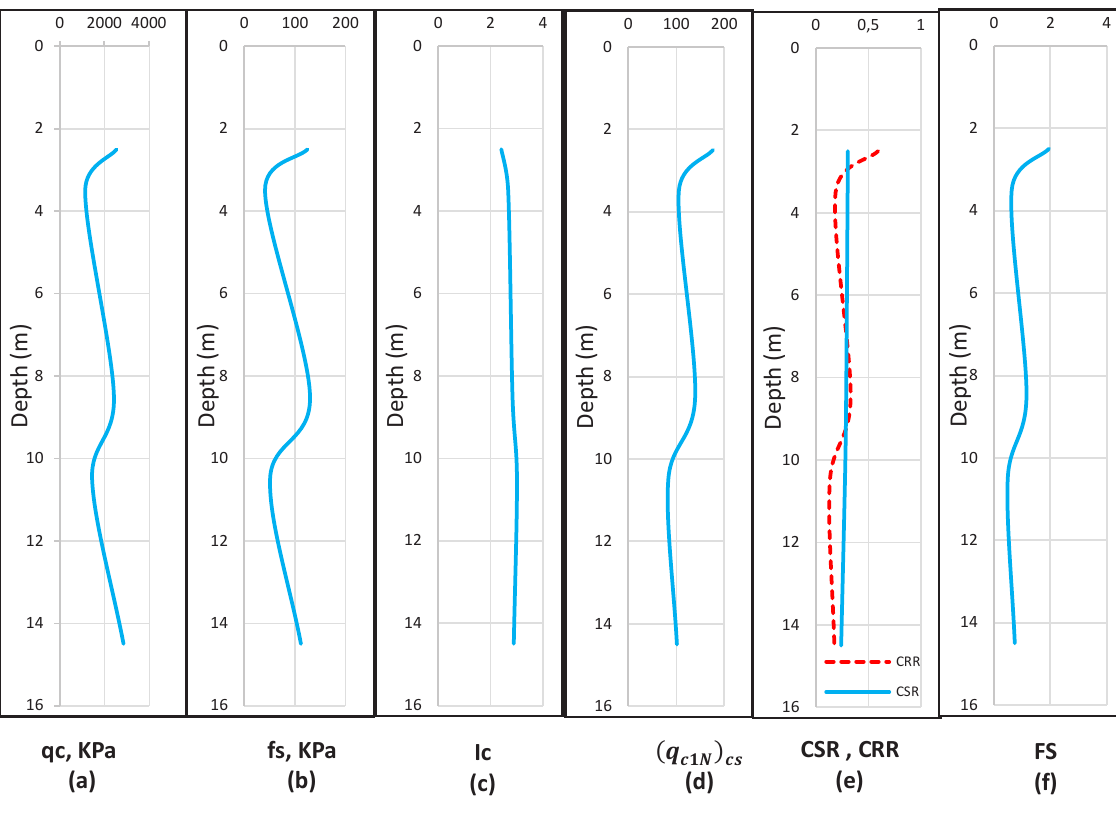
Figure 2: Example plots showing key steps in calculating liquefaction potential at one CPT (BH34): (a) tip resistance (qc); (b) side friction (fs); (c) soil type index (Ic); (d) corrected equivalent tip resistant ( q safety